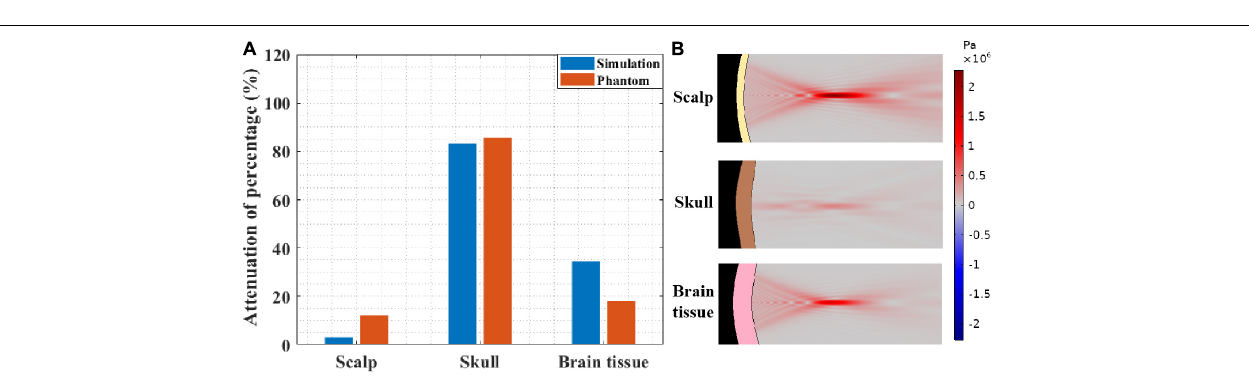
FIGURE 8 | (A) Ultrasound attenuation percentage of different head tissues (thicknesses of scalp, skull and brain tissues are 3.35 and 5 mm and 4 cm, respectively). (B) The sound pressure distribution in scalp, skull, and brain tissue,